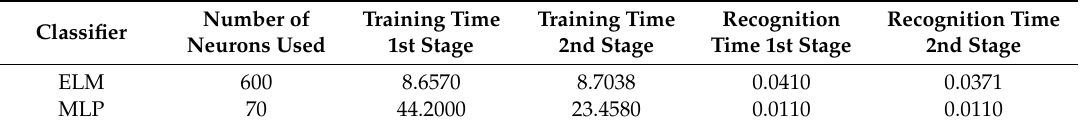
Table 6. Classifier execution